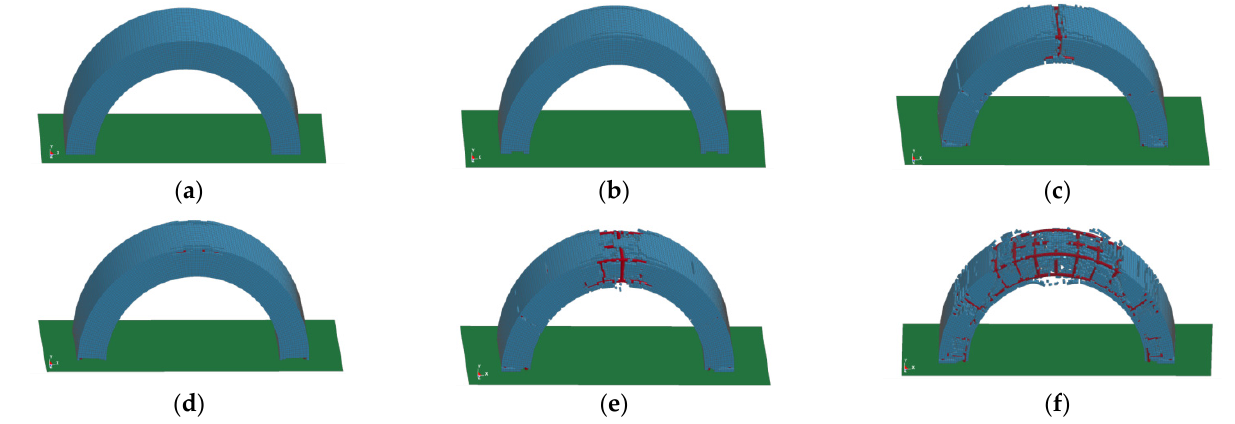
Figure 8. Macroscopic damages under various working conditions. ( a ) 0.5 kg TNT, 0.4 m; ( b ) 1 kg TNT, 0.4 m; ( c ) 3 kg TNT, 0.4 m; ( d ) 0.2 kg TNT, 0.15 m; ( e ) 0.5 kg TNT, 0.15 m; ( f ) 1 kg TNT,